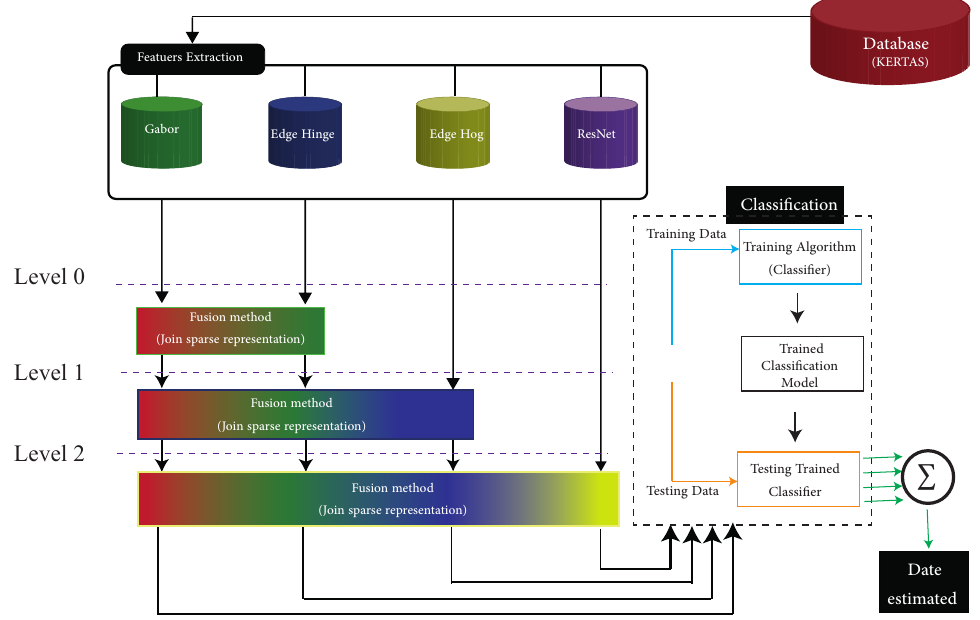
Figure 1. Overview of our proposed